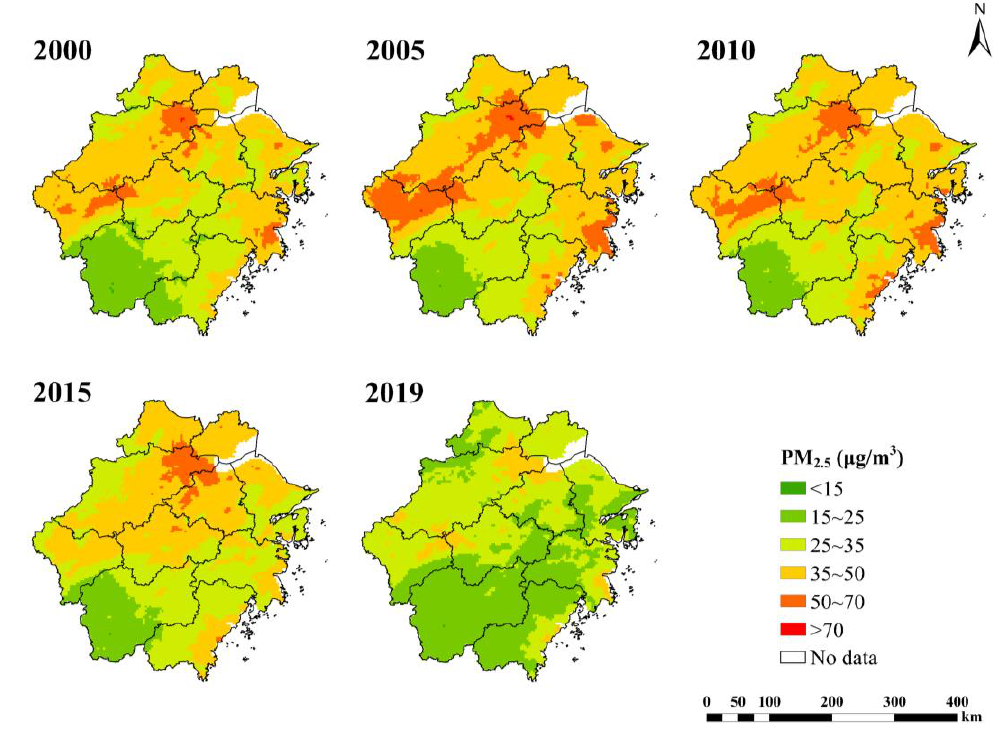
Figure 3. Spatial distribution map of PM 2.5 concentrations in Zhejiang Province for selected years during 2000–2019. Table 2. Results of the 10-fold cross-validation evaluation indices in five